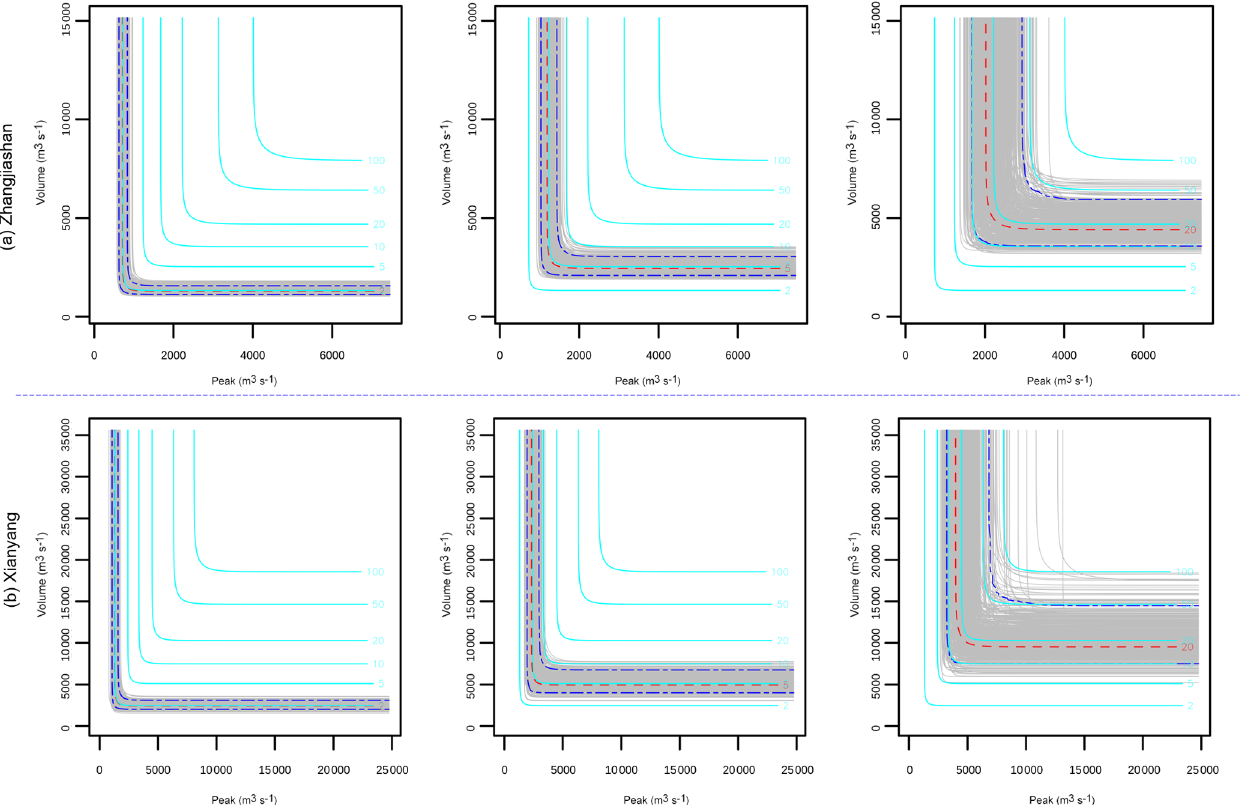
Figure 5. Uncertainty quantification of the joint RP in “OR”: the red dash lines indicate the predictive means, the two blue dash lines, respectively, indicate the 5% and 95% quantiles, and the grey lines indicate the predictions under different parameter samples with the same joint RP of the red and blue dash lines. The cyan lines denote the predictions under different return periods, with the model parameters being their mean